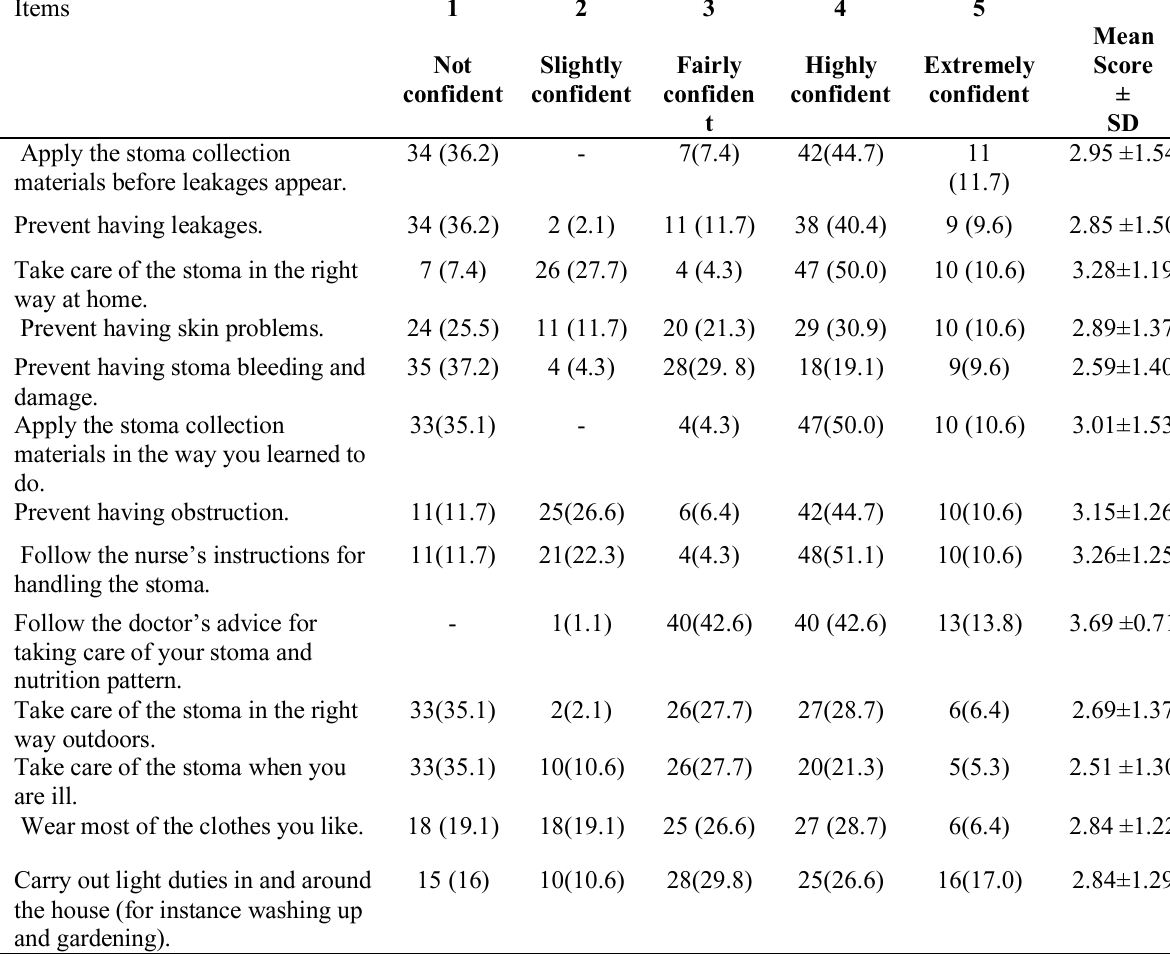
Table 6: Ostomates Self Care Efficacy N =94